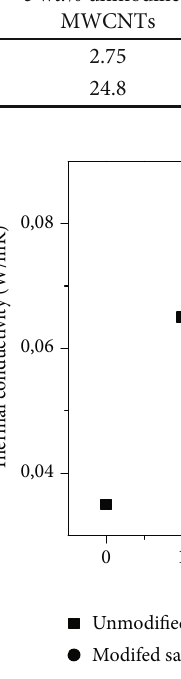
Figure 4: Thermal conductivity of modi fi ed 3wt.% MWCNT nanocomposite and unmodi fi ed nanocomposites at various MWCNT